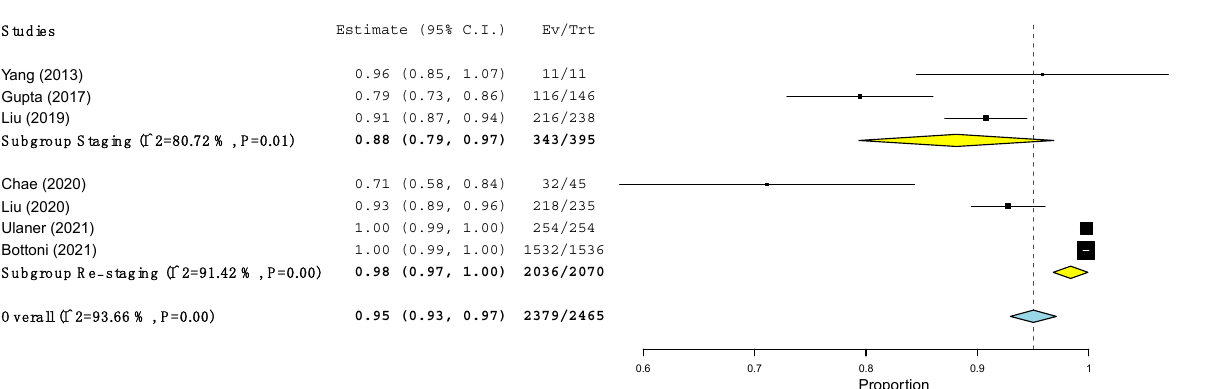
Figure 4. Sensitivity of 18 F-FDG PET/CT at the level of the lesions across studies.